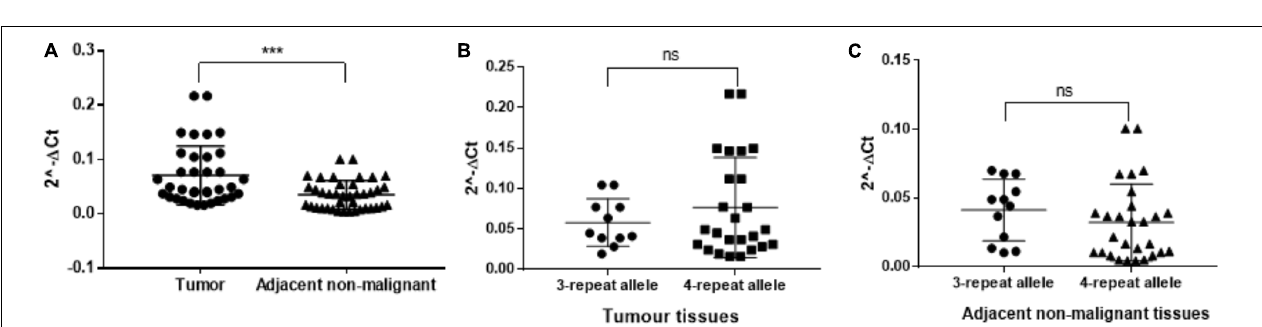
FIGURE 3 | RT-qPCR from twenty patient tissue samples for TTTTG- TRIB1 . Expression of the (A) TRIB1 gene in tumor tissues when compared to adjacent non-malignant tissues and expression of the 3- and 4-repeats alleles in (B) tumor tissues and (C) adjacent non-malignant tissues. ∗∗∗ P = 0.0005, value calculated using the Mann–Whitney test (GraphPad Prism